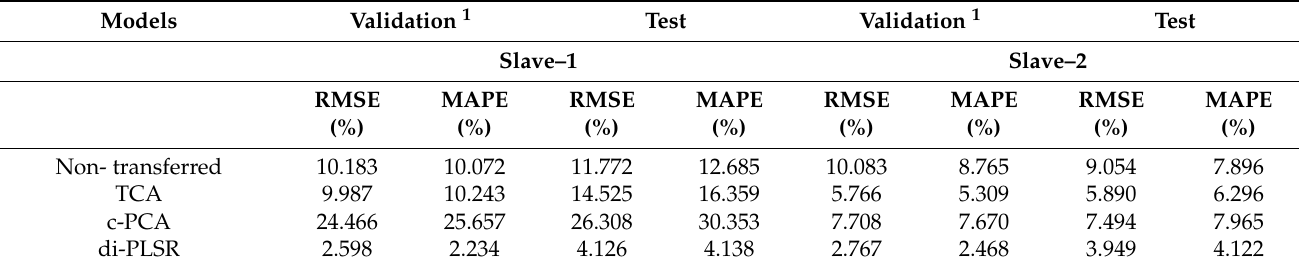
Table 1. Evaluation of RWC predictions obtained via TCA, c-PCA, and di-PLSR with reference to the master predictions.